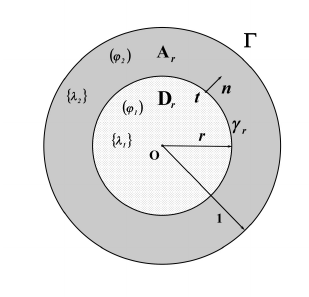
Figure 1. A section of a bounded 2D